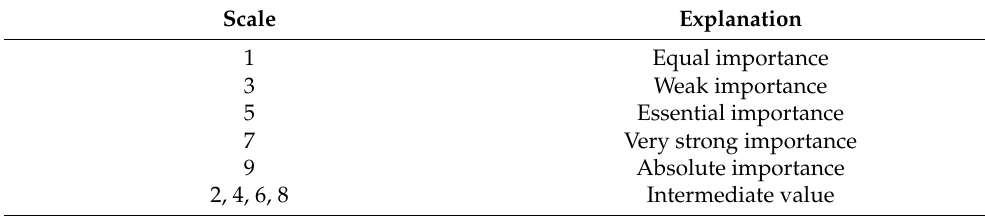
Table 3. Scale explanation